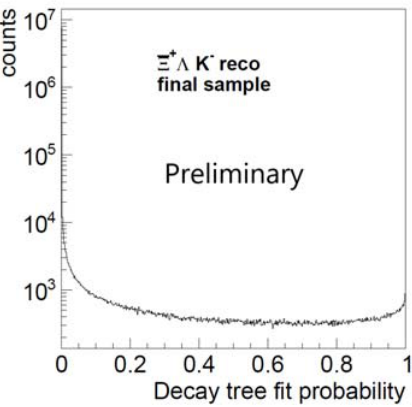
Figure 2. Decay tree fit probability.